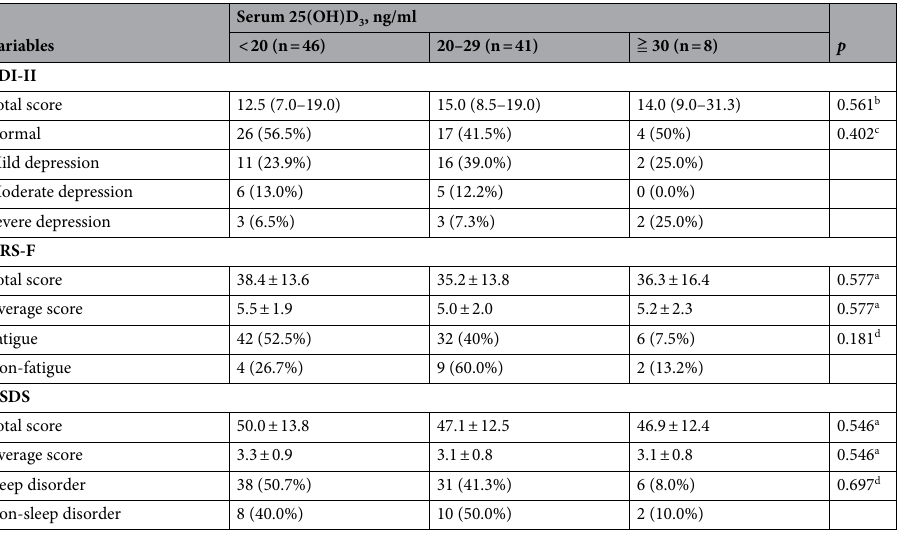
Table 6. Participant questionnaire score according to 25(OH)D 3 concentrations. BDI-II, Beck Depression Inventory II; NRS-F, Numerical Rating Scale for Fatigue; GSDS, General Sleep Disturbance Scale. * p -value < 0.05. The power after calculation and analysis after the event: the number of subjects is 95 (n = 95), and the ANOVA test is carried out in three groups, and the calculated power is 0.6550386. a Data were continuous and presented as mean ± SD using ANOVA. b Data were continuous and presented as median (IQR) using Kruskal–Wallis test. c Data were categorical and presented as n (%) using Fisher’s exact test. d Data were categorical and presented as n (%) using chi-squared